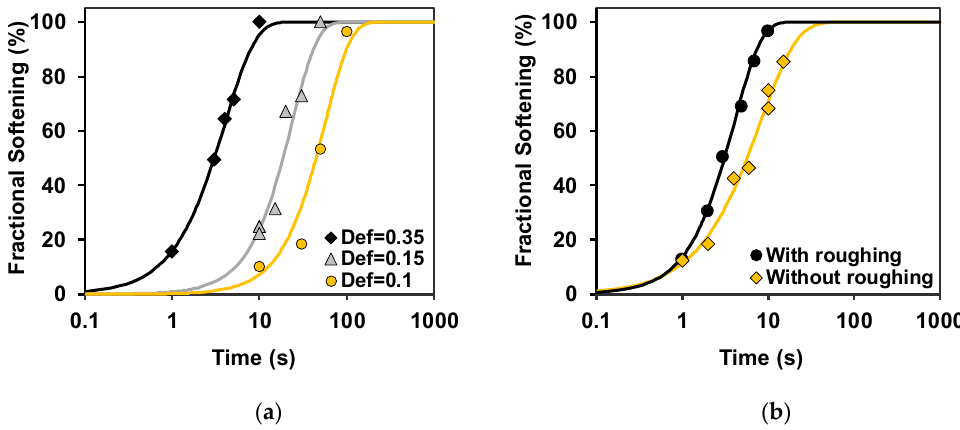
Figure 7. Examples of the effect of strain and of initial microstructural refinement on the softening curves. ( a ) Ti10Nb3 steel, T = 1100 °C, roughing pass applied, 𝜀(cid:4662) =1 s − 1 and ( b ) Ti10Nb3 steel, T = 1100 °C, 𝜀 = 0.35, 𝜀(cid:4662) = 1 s − 1 .